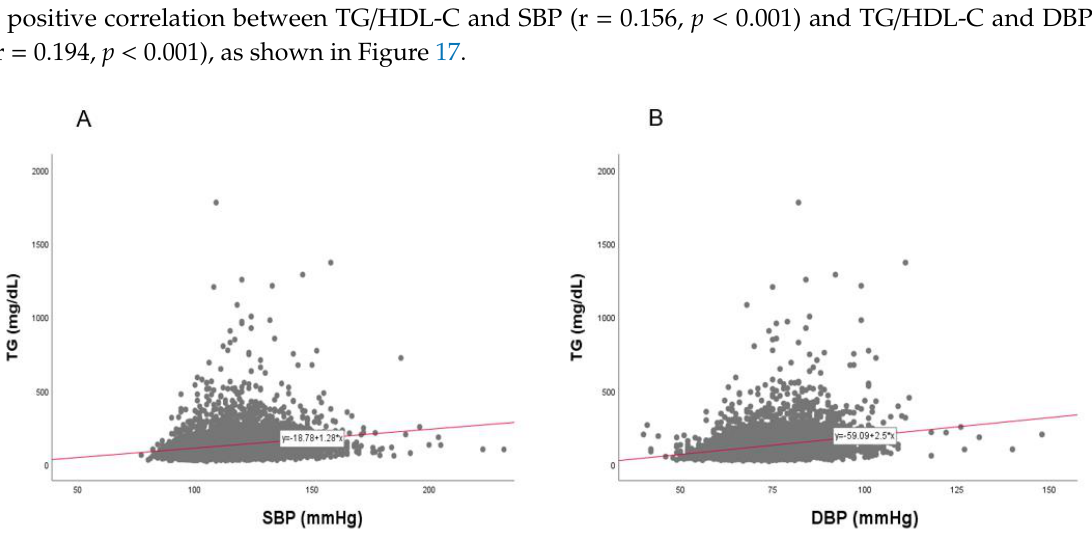
Figure 13 . Pearson’ s correlation analysis between total cholesterol (TC) and diastolic blood pressure (DBP) in men ( A ) and women ( B ). The men (A) showed r = 0.226 ( p < 0.001) and women (B) showed r = 0.192 ( p < 0.001) between DBP and TC.